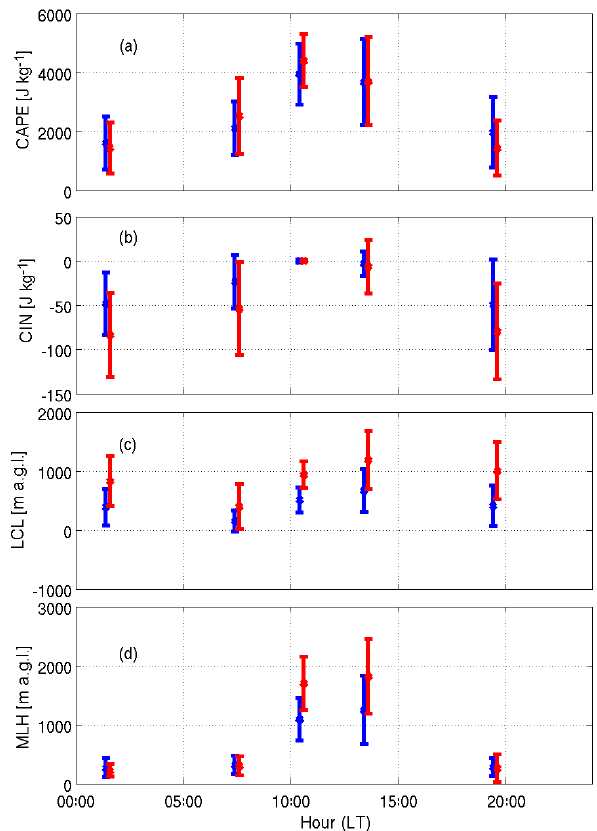
Figure 3. Diurnal cycles (mean and standard deviation) for radiosonde-based thermodynamic quantities of (a) CAPE, (b) CIN, (c) LCL height and (d) MLH for wet (blue) and dry (red) season